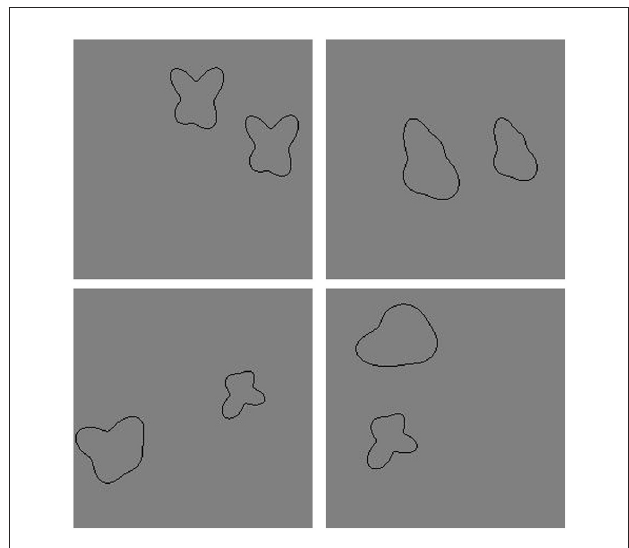
FIGURE1 Sample images used during training in Experiment 1a. (Top) Two “Same” images. (Bottom) Two “Different” images.